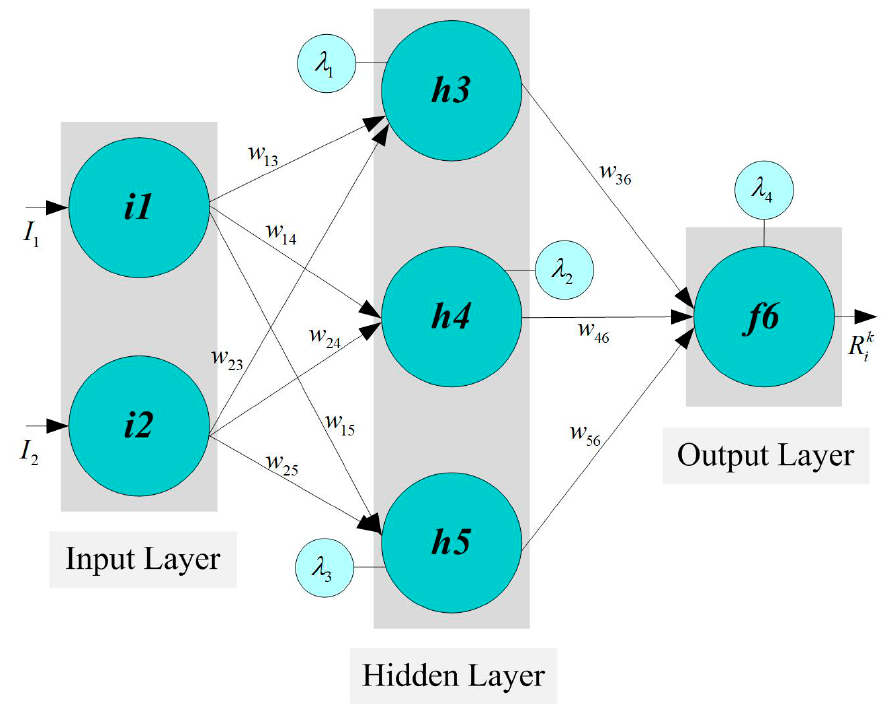
Figure 10. ANN architecture representation [28,40].